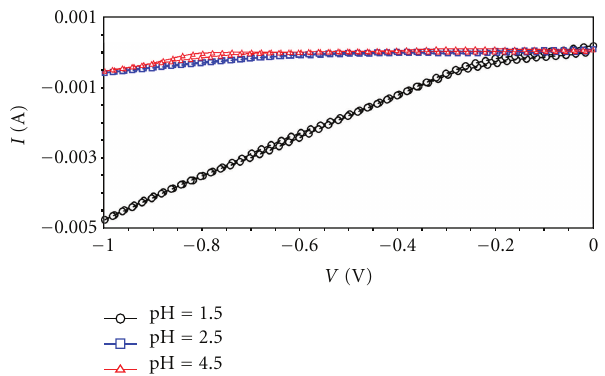
Figure 1: Cyclic voltammograms of solution containing 5mL of 0.1M CuCl 2 , 5mL of 0.1 M InCl 3 , and 150 mL of 0.1 M NaS 2 O 3 at di ff erent pHs with 25 mV/s scan rate.